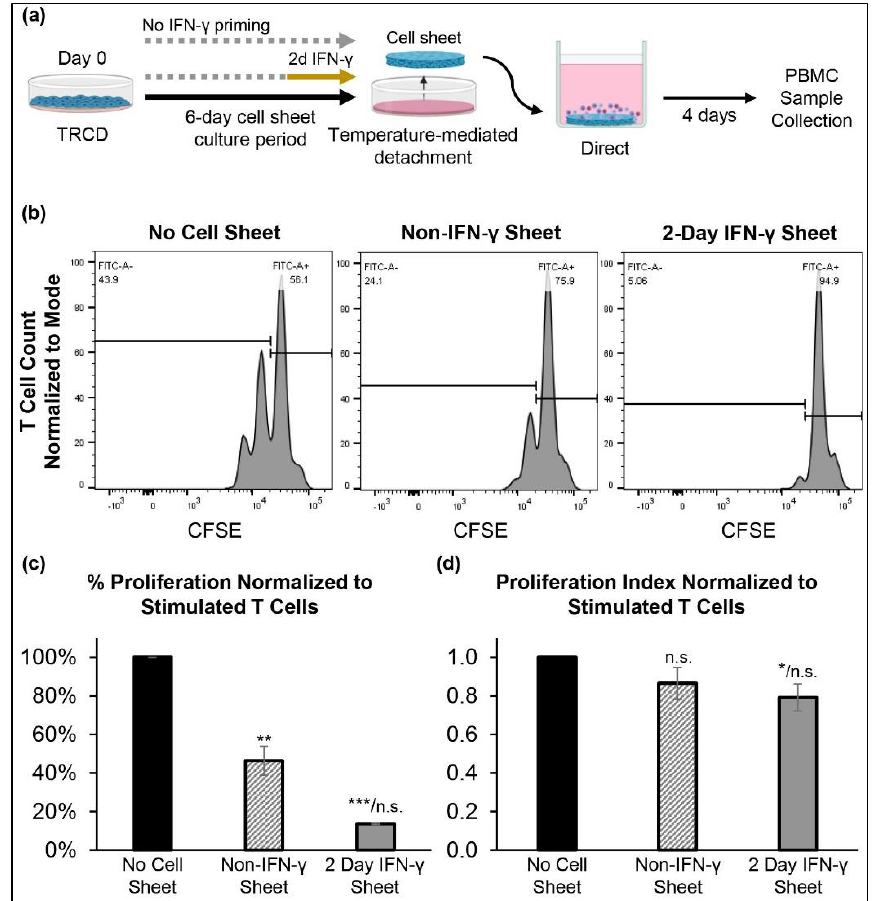
Figure 5. Non-IFN- γ and IFN- γ primed hBMSC sheets exhibit enhanced immunosuppressive activity in direct coculture with hPBMCs. ( a ) Experimental schematic of hcBMSC sheet fabrication and T cell proliferation coculture assay. ( b ) Representative flow cytometry plots of gated T cells − /+ hcBMSC sheet indirect coculture. Quantification of ( c ) percent proliferated T cells (divided cells) and ( d ) proliferation index normalized to stimulated T cells in PBMC control, no coculture, group. Error bars represent means ± SD ( n = 3, independent experiments) (n.s. p ≥ 0.05, * p < 0.05, ** p < 0.01, *** p < 0.001). Statistical analysis p values are represented as compared to no cell sheet / non-IFN- γ sheet.